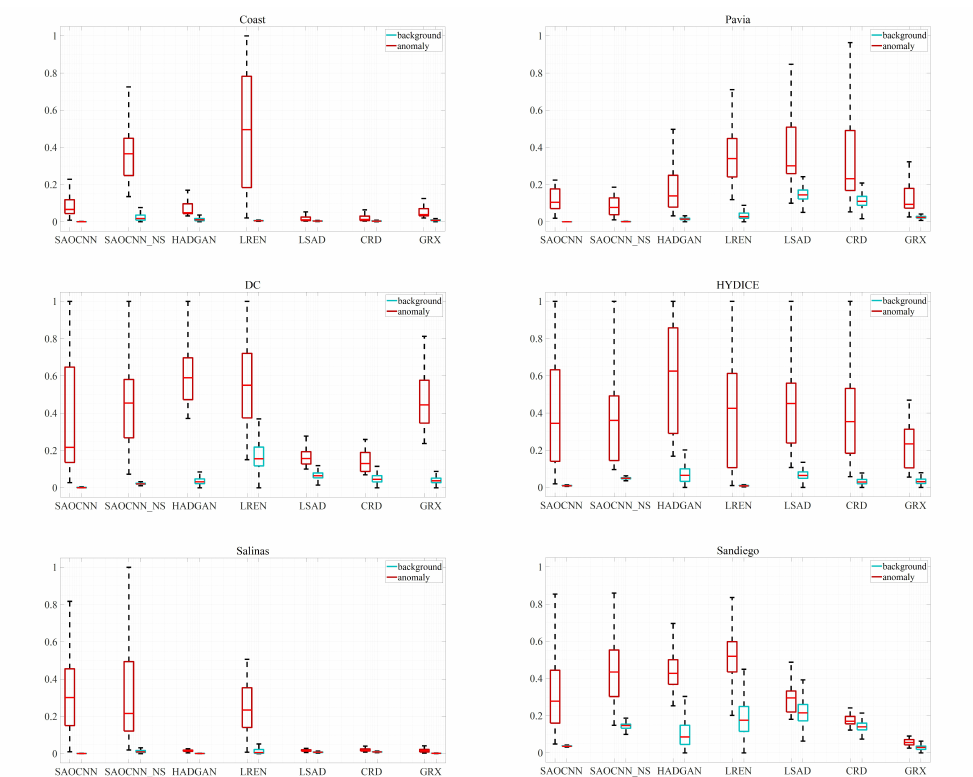
Figure 9. Box plots for SAOCNN, SAOCNN_NS, HADGAN, LREN, LSAD, CRD, and